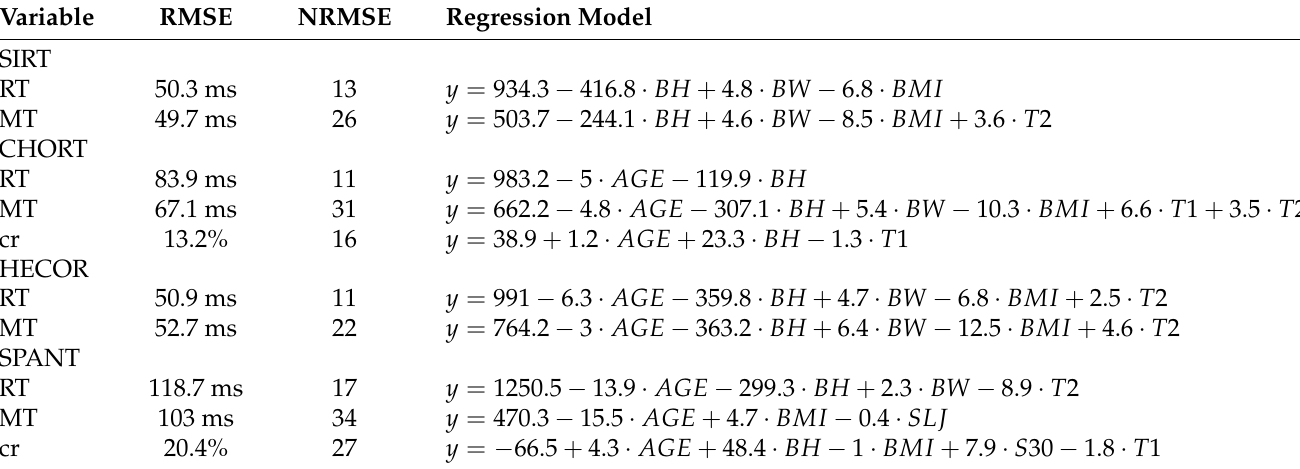
Figure 1. Correlations graph. Table 5. Forward selection multiple regression